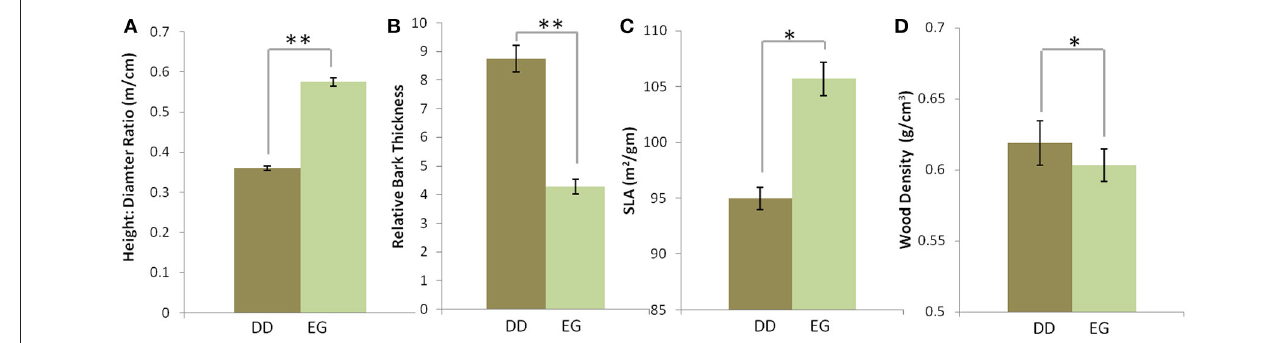
FIGURE 2 | Comparisons of functional traits of trees from dry deciduous “forest” (DD; 79 species) and evergreen forest (EG; 92 species) across seven sites in Southern India. The data shown (Mean ± SE) are for (A) height: diameter ratios, (B) relative bark thickness, (C) specific leaf area, and (D) wood density. Asterisks indicate significant differences between mean trait values in DD and EG habitats (* p < 0.05, ** p <